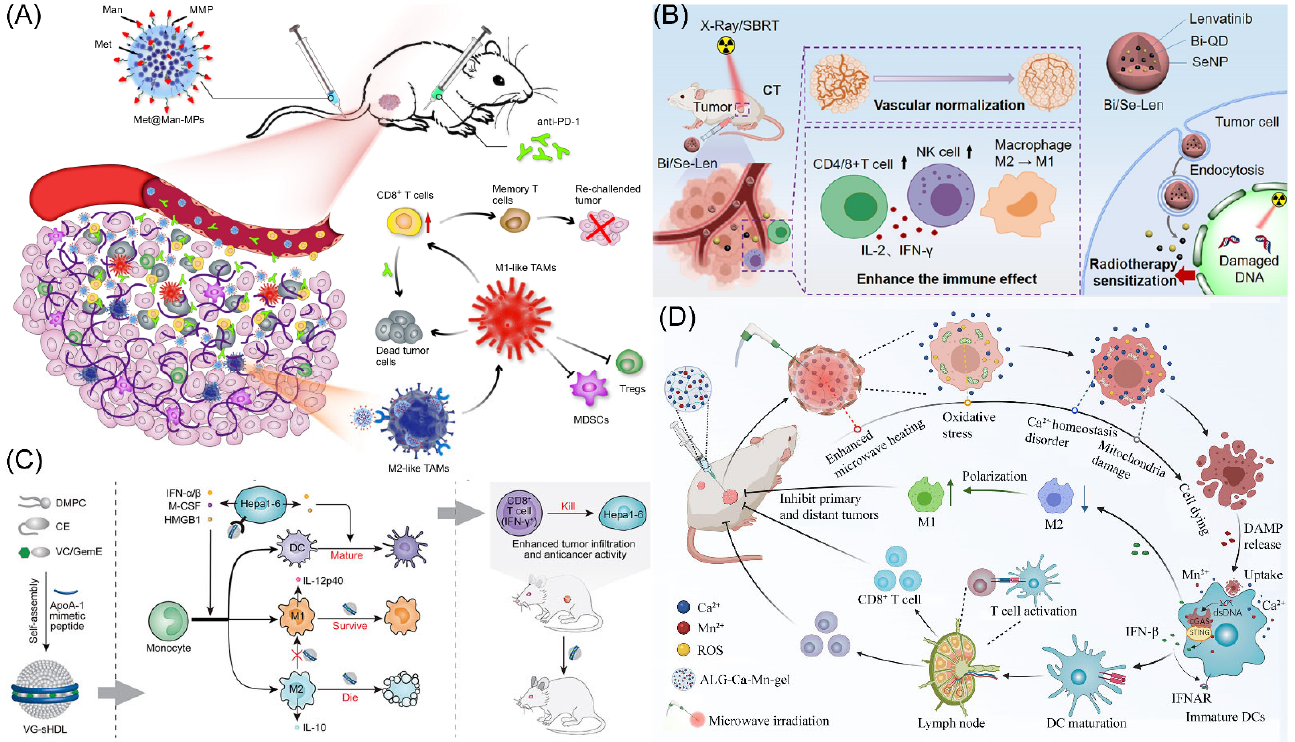
Figure 1. ( A ) Schematic representation of Met@Man ‐ MPs acting as an effective drug to support anti ‐ PD ‐ 1 treatment. Copyright 2021, Springer Nature [17]. ( B ) Schematic illustration of the radio sensi ‐ tization mechanisms of Bi/Se ‐ Len NPs in HCC. Copyright 2021, American Chemical Society [24]. ( C ) The design and function of sHDL are depicted schematically. Copyright 2021, Elsevier Ltd. [25]. ( D ) The diagram showing how the metallo ‐ alginate hydrogel improves tumor microwave ablation therapy and enhances anti ‐ tumor immunity. Copyright 2022, American Association for the Ad ‐ vancement of Science (AAAS)